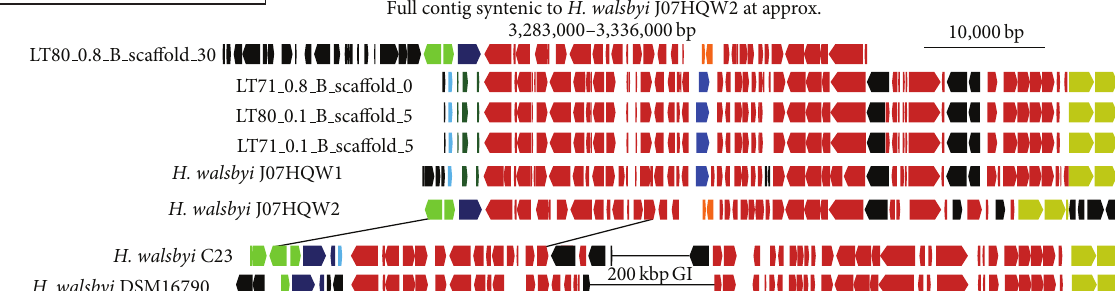
previously been identified as a genomic island [20].